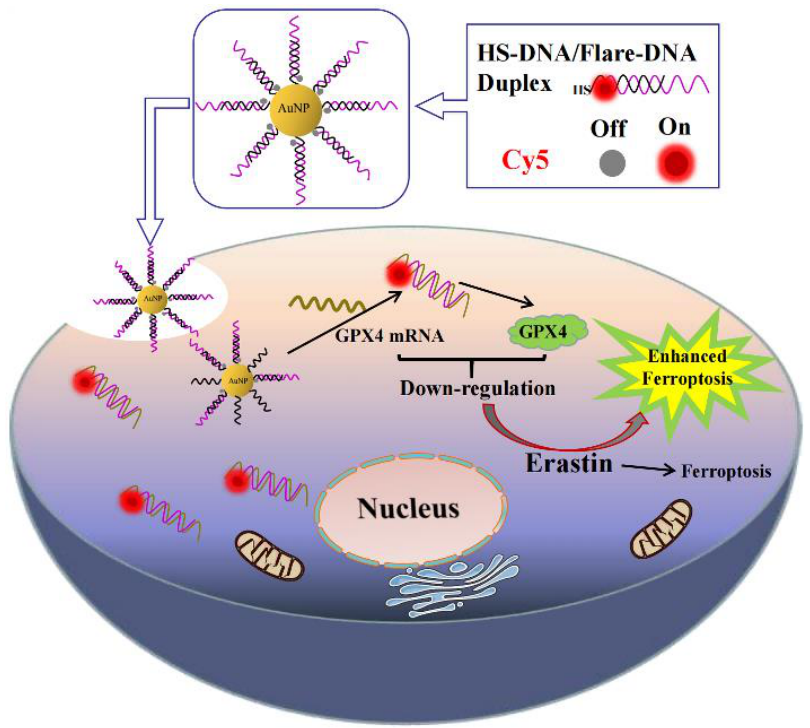
Figure 1. Schematic illustration of designation of AuNF probes, mechanism of down-regulating GPX4, and enhancement of erastin-induced ferroptosis for cancer cells.